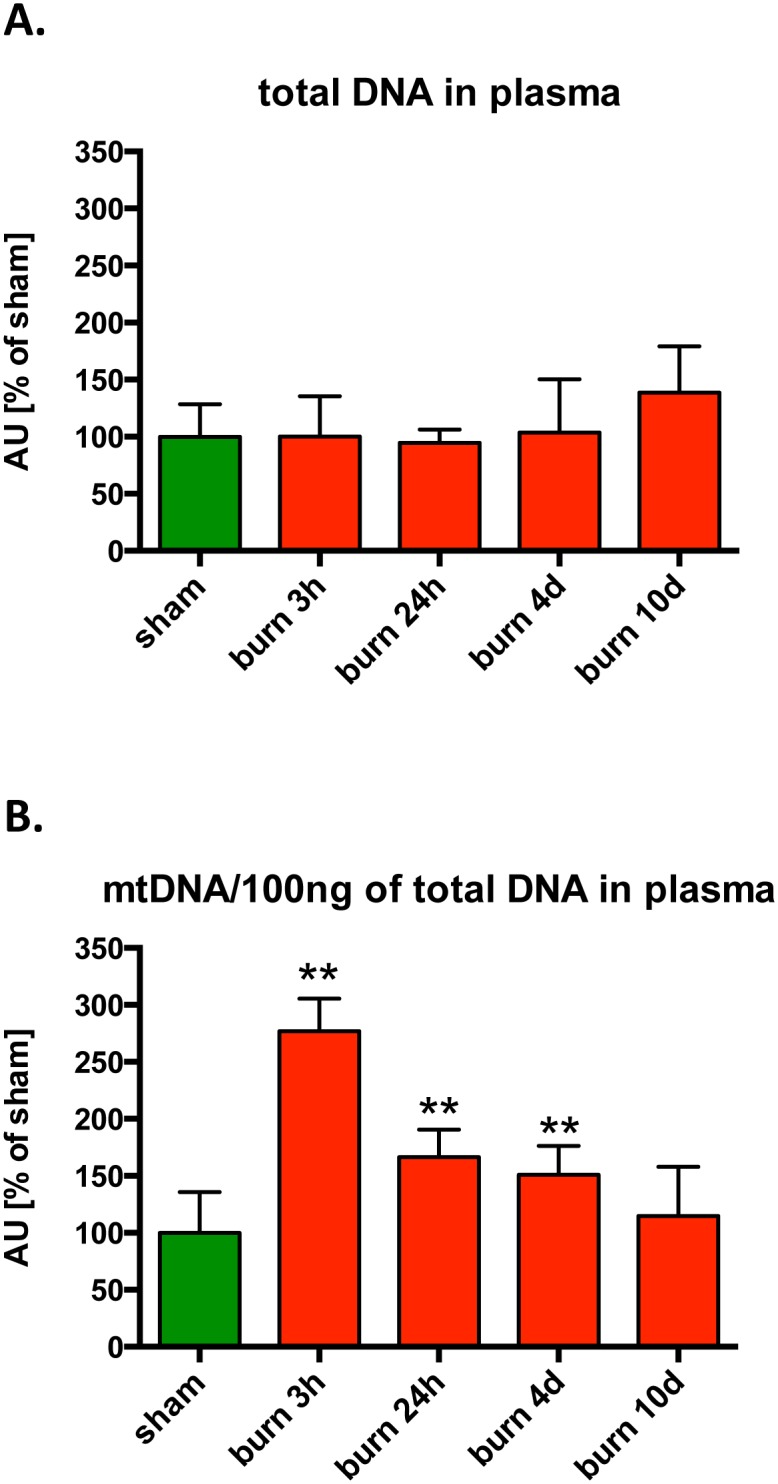
Changes in circulating total and mitochondrial DNA in response to burn injury.The amount of (A) total DNA and (B) mitochondrial DNA fragments in plasma of mice subjected to burn injury was analyzed using qPCR. The results are based on n = 6 per group and represent mean±SD. *, ** p<0.05 and p<0.01 respectively, relatively to sham treated animals.